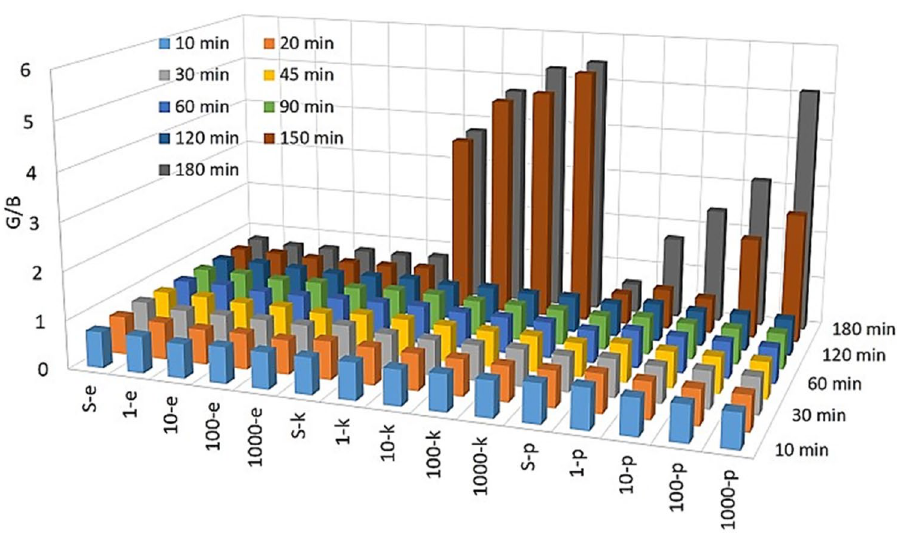
Figure 3. Colorimetric readouts of test 2 with RGB analysis for detection of E. coli, K. pneumoniae and P. mirabilis